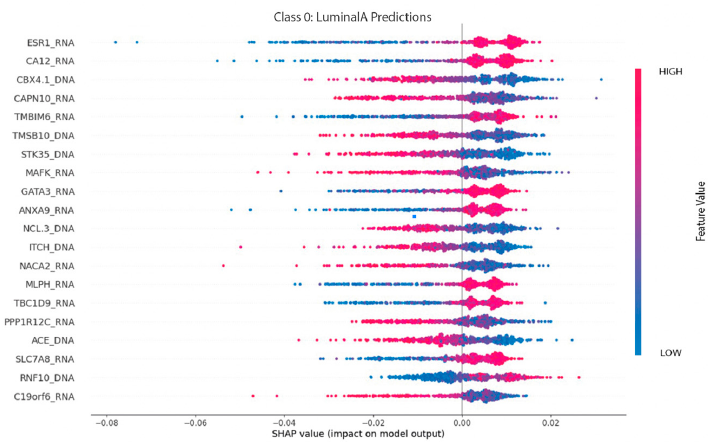
Figure 11. SHAP plot for luminal A prediction.